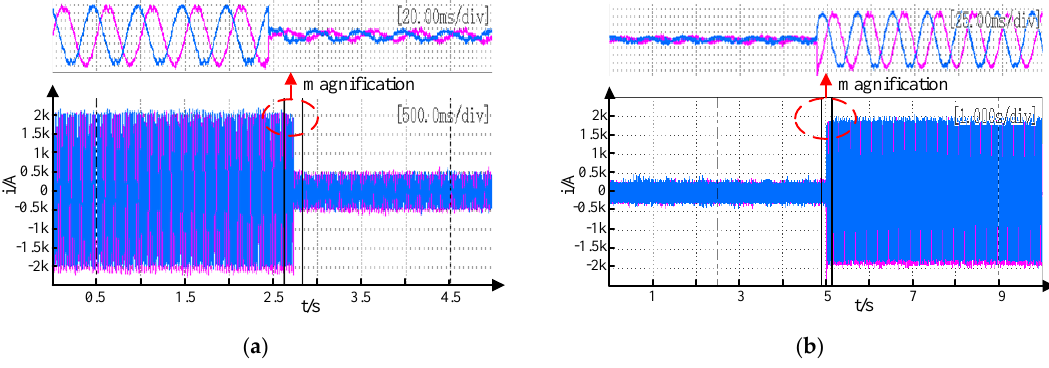
Figure 17. Output two-phase current waveform: ( a ) 40 MVar to 10 MVar; ( b ) 10 MVar to 40 MVar.